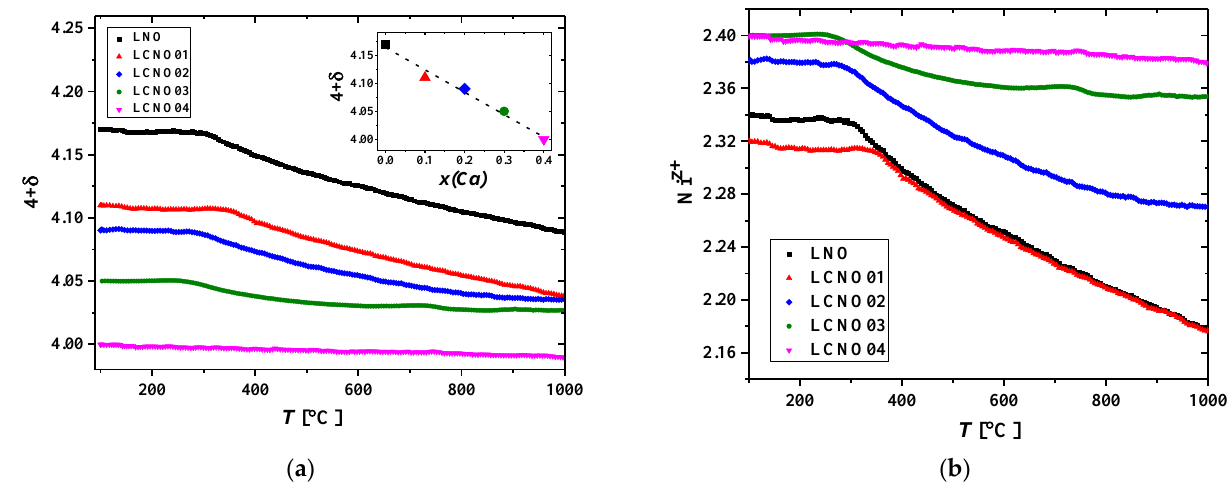
Figure 4. Temperature dependences of oxygen stoichiometry ( a ) and formal Ni oxidation state ( b ) for the La 2−x Ca x NiO 4+δ series calculated from the TGA data collected upon heating in air.